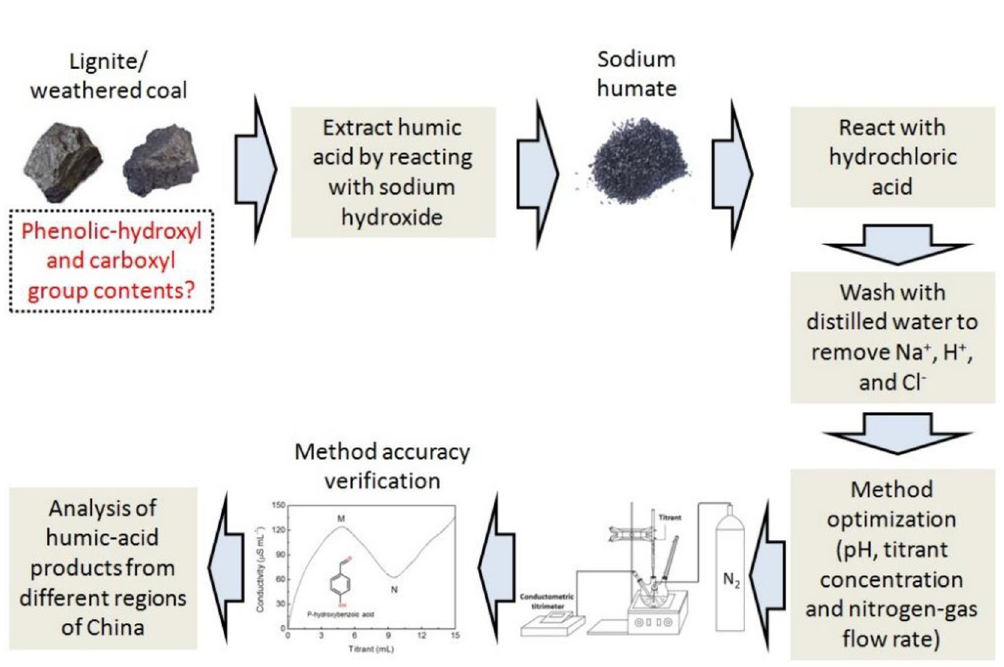
Fig 3. Scheme of the study